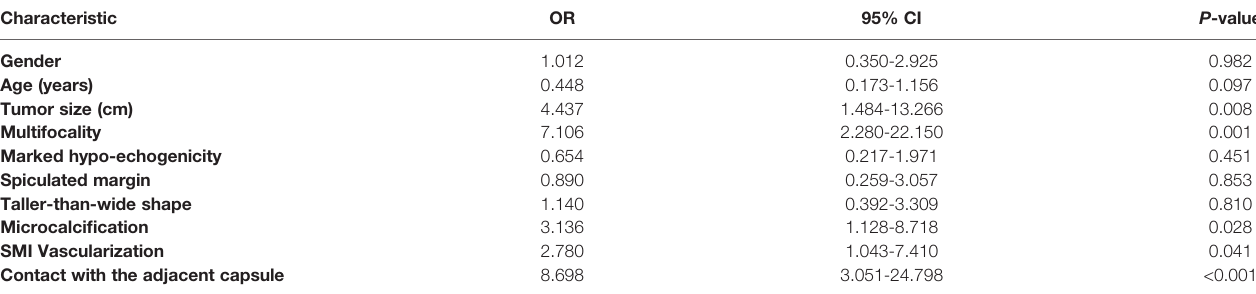
TABLE 3 | Multivariate analysis of ultrasonographic characteristics of CLNM from PTCs. Characteristic OR 95% CI